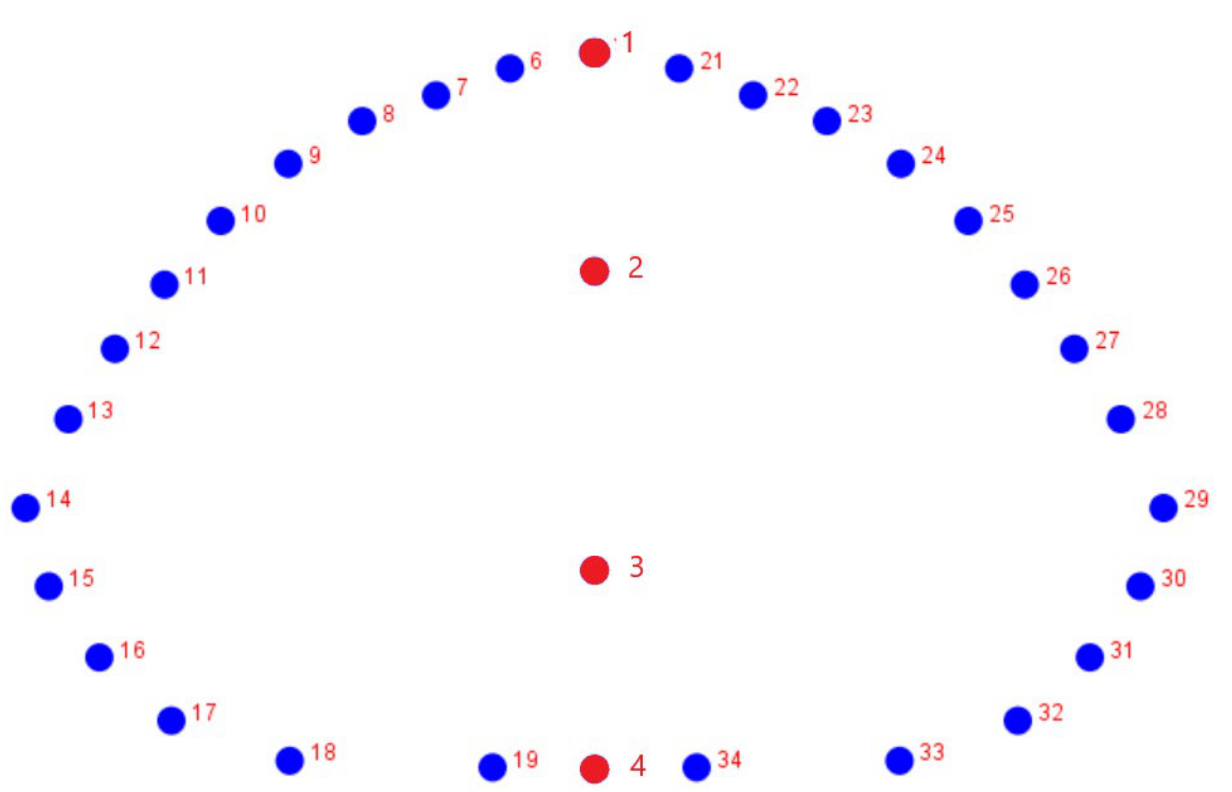
Figure 1. Landmarks configuration used in the study composed of 4 fixed landmarks (1 to 4) and two 15 semilandmark-curves imposed onto a 2D picture of Testudo sp. Frontal view.